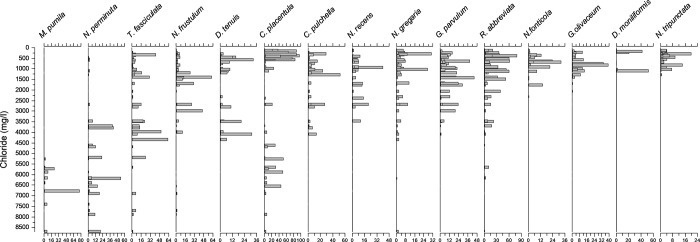
Relative abundances (percentages) of the most common species along the salinity gradient in the complete dataset (all-seasons).